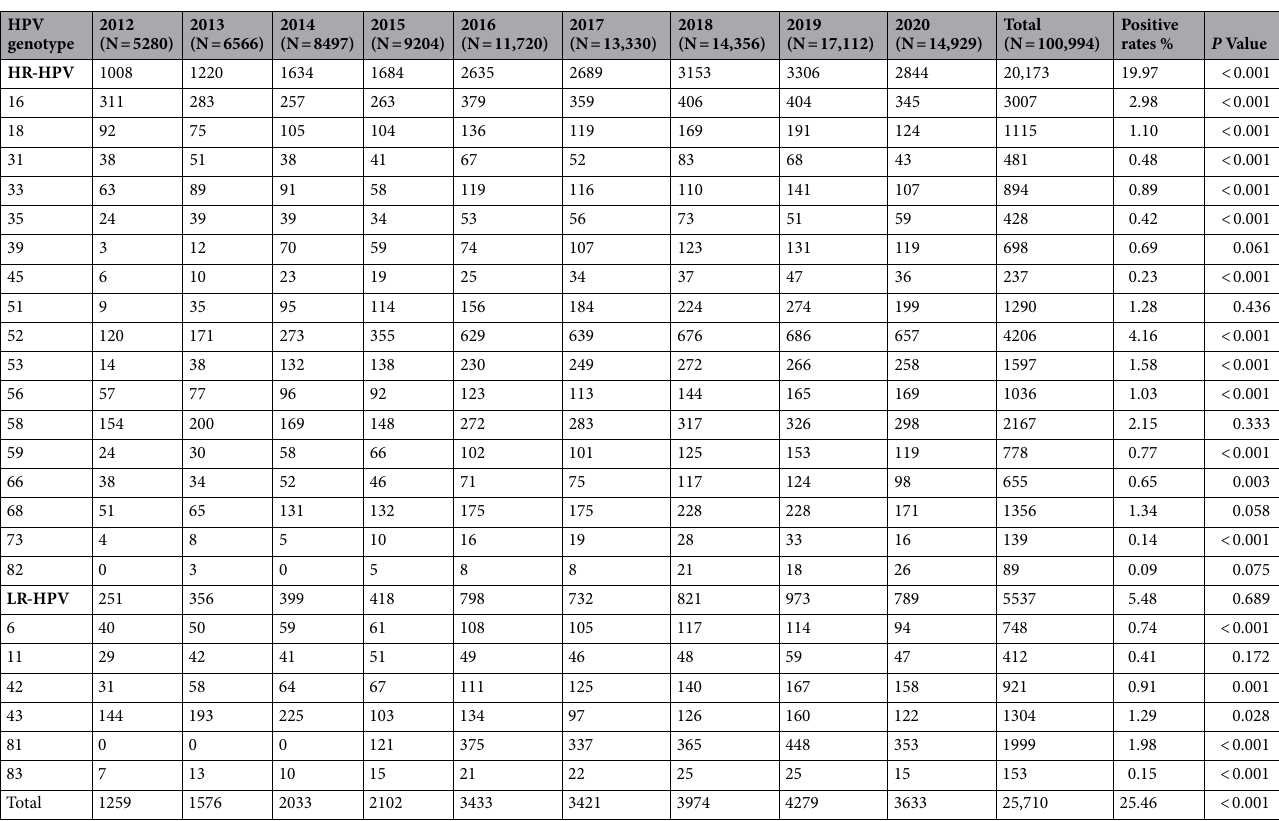
Table 3. Positivity of HPV genotypes from 2012 to